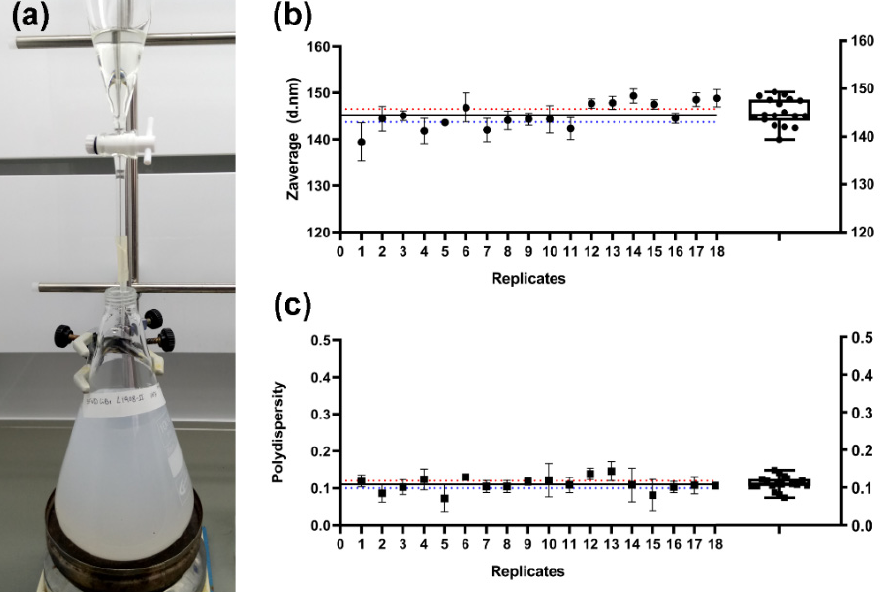
Figure 2. Preparation of the silk fibroin nanoparticles. ( a ) Photograph of the SF desolvation in methanol. ( b , c ) Values of the hydrodynamic characteristics of the prepared SFN (six replicates/batch) presented as mean ± SD of three independent measurements. ( b ) Zave (diameter in nm). ( c ) Polydispersity. Blue and red dotted lines represent the lower and upper 95% of the confidence interval (CI) of the mean, respectively. The black line represents the mean of all values (n = 18). Box and whiskers plot (10–90 percentile) is also included.